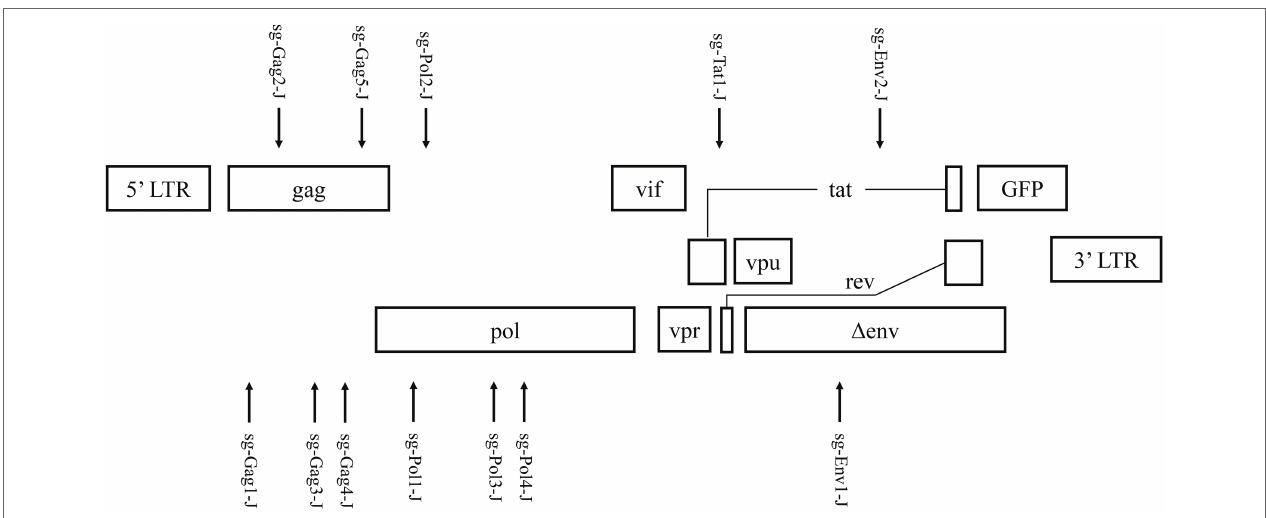
FIGURE 1 | Targeting the HIV-1 genome using Cas9/single guide RNA (sgRNA) in J-Lat 10.6